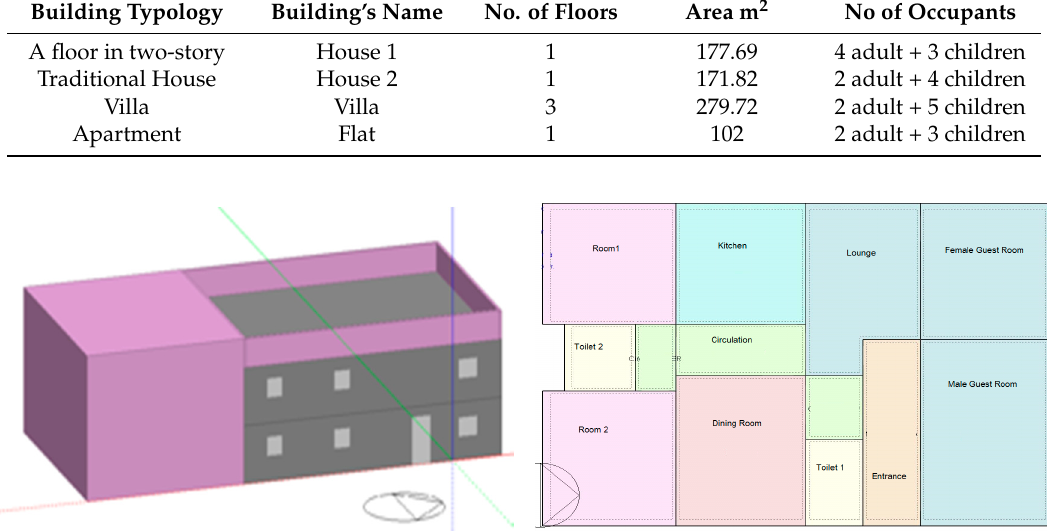
Figure 7. The plan and geometric description of Villa.